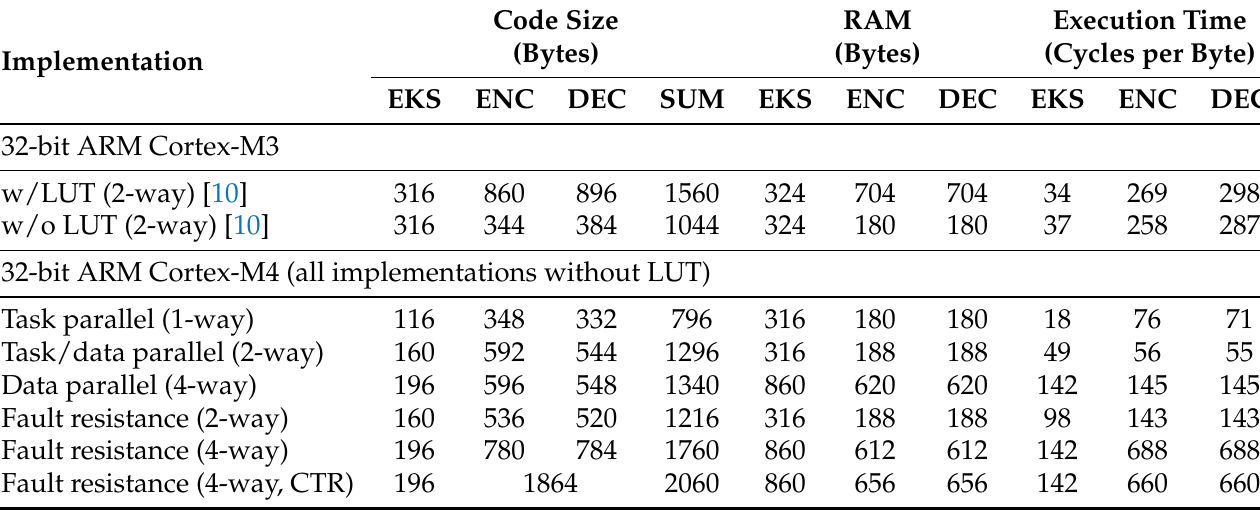
Table 3. Performance evaluation of HIGHT algorithm on ARM Cortex-M series in terms of RAM (bytes), execution time (clock cycles), and code size (bytes). EKS, ENC, DEC, and SUM represent encryption key scheduling, encryption, decryption, and summation, respectively.